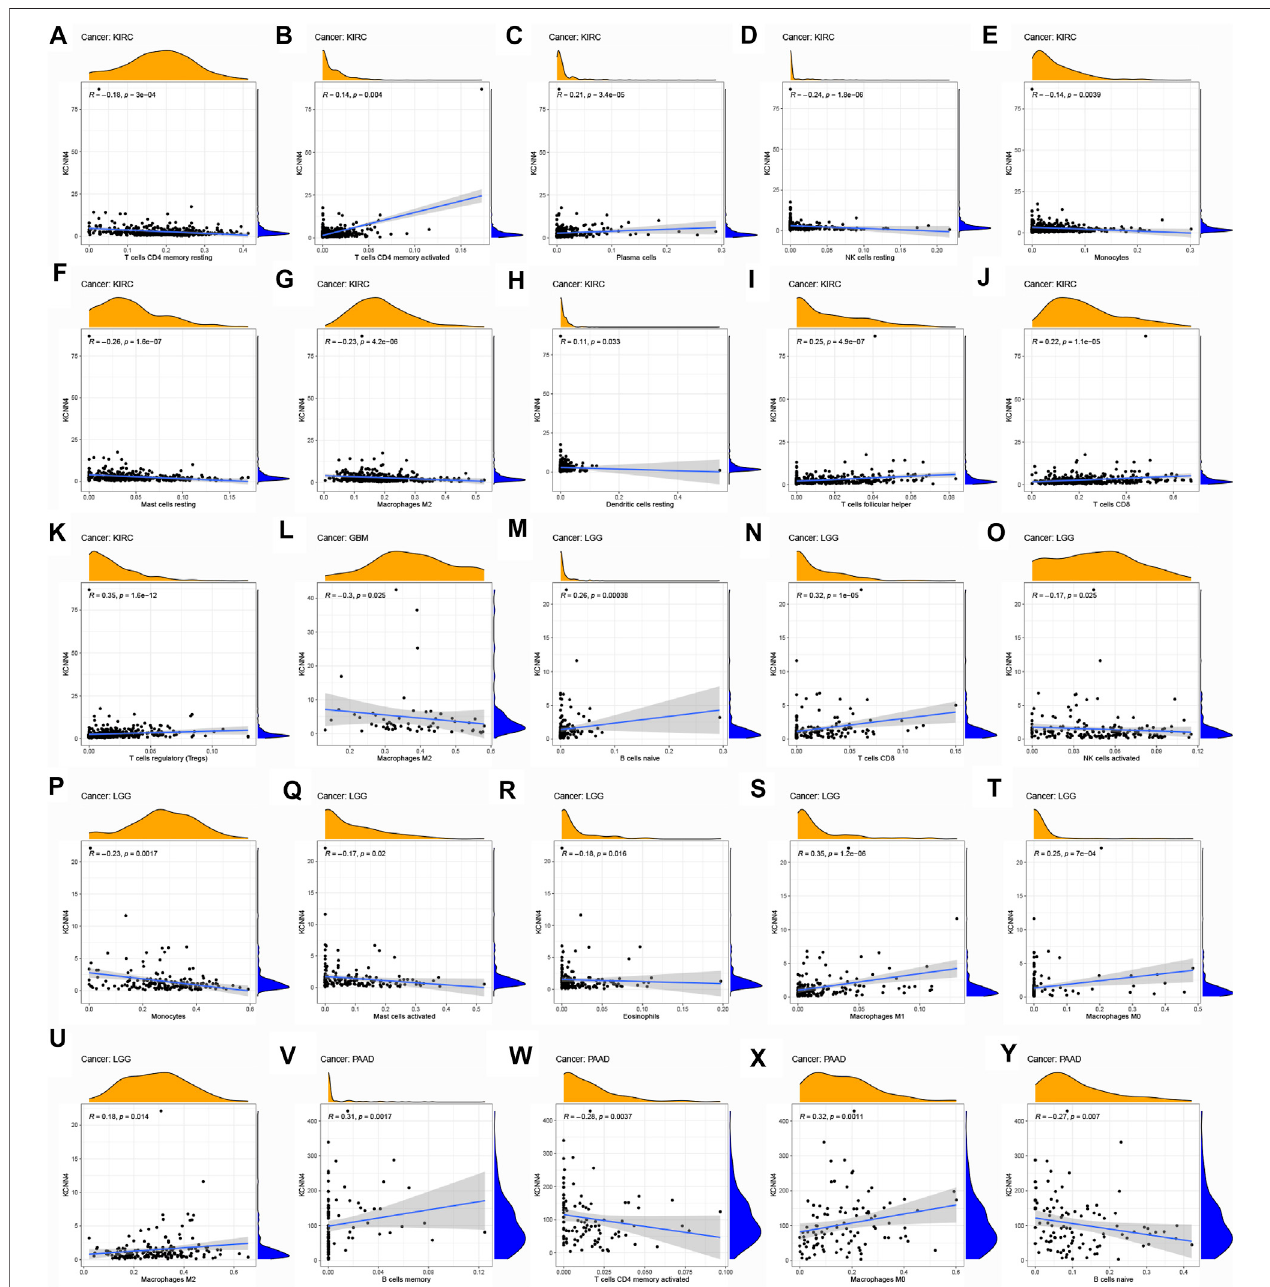
FIGURE 9 | Association of TIC subtype with KCNN4 expression in increased-risk group. (A – K) Association of each TIC subtype with KCNN4 expression in KIRC. (L) AssociationofeachTICsubtypewithKCNN4expressioninGBM. (M – U) AssociationofeachTICsubtypewithKCNN4expressioninLGG. (V – Y) Associationofeach TIC subtype with KCNN4 expression in